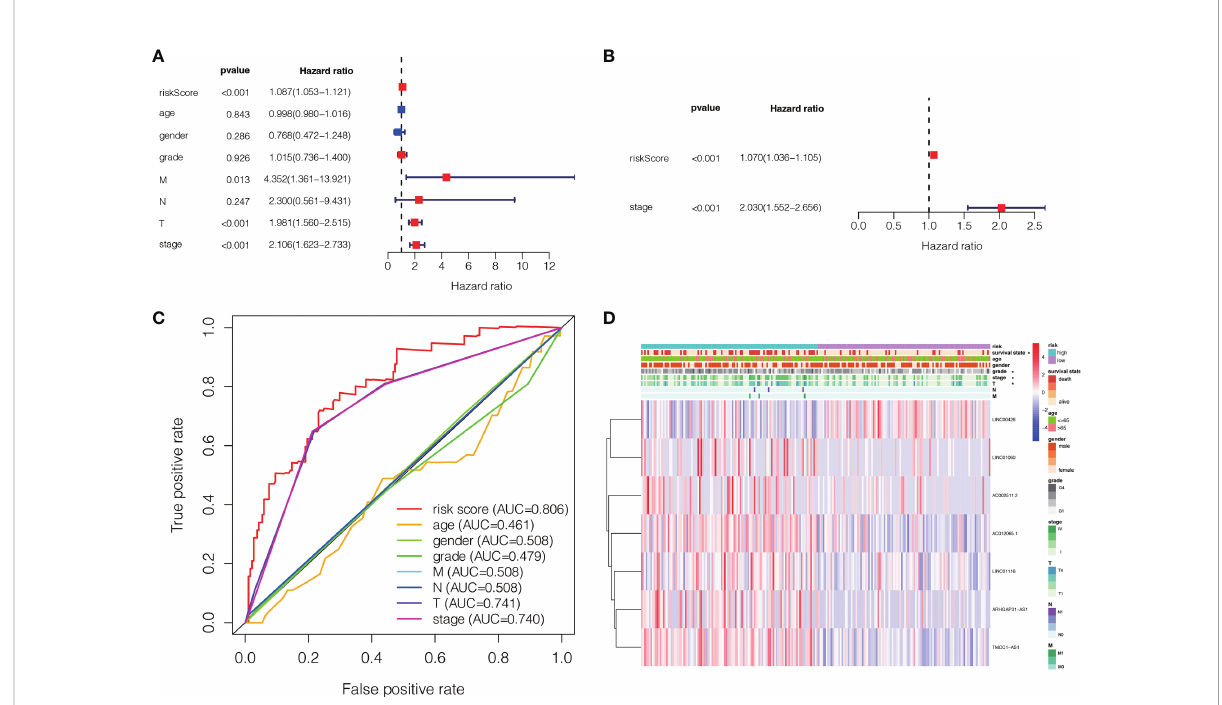
FIGURE 7 The association between the ALPS and the prognosis of liver individuals. (A) Forest plot for univariate Cox regression assessment. (B) Forest plot for multivariate Cox regression analysis. (C) The ROC curve of the risk score and clinio-pathological factors. (D) Heatmap of the ALPS and clinical signi fi cance in the combined group. T, tumor; N,